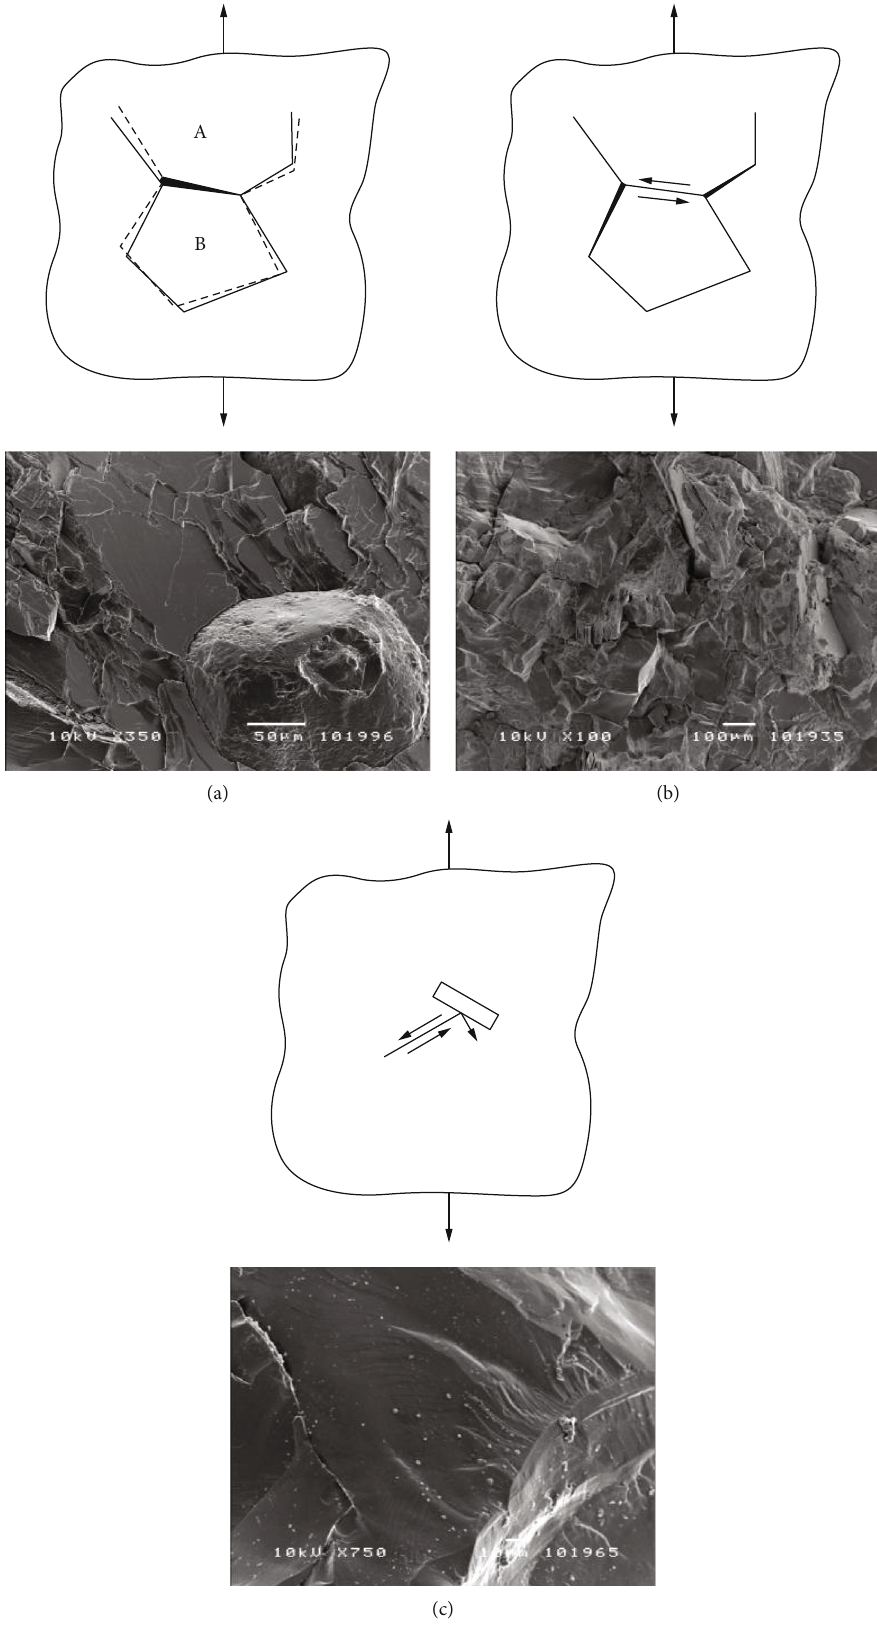
Figure 22: Example crack nucleation caused by